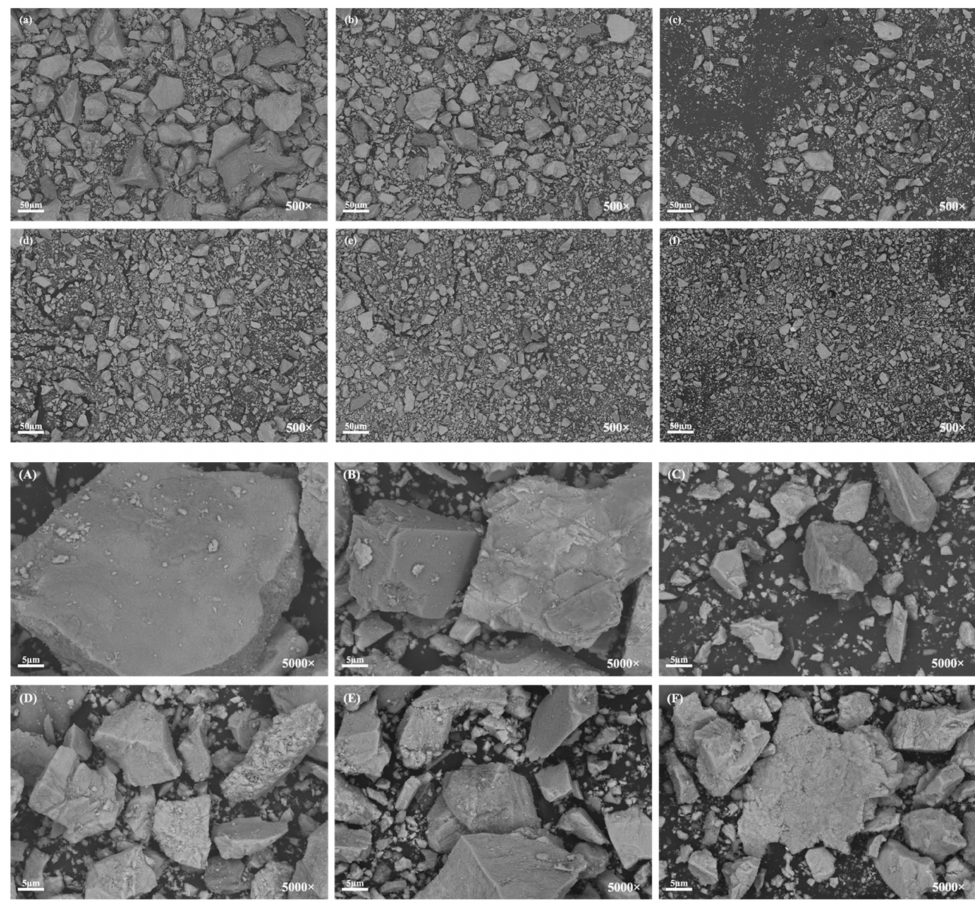
Figure 5. Particle morphology of LVTC powder ground for different times: ( a , A ) 0 min; ( b , B ) 10 min; ( c , C ) 20 min; ( d , D ) 30 min; ( e , E ) 40 min; and ( f , F ) 50